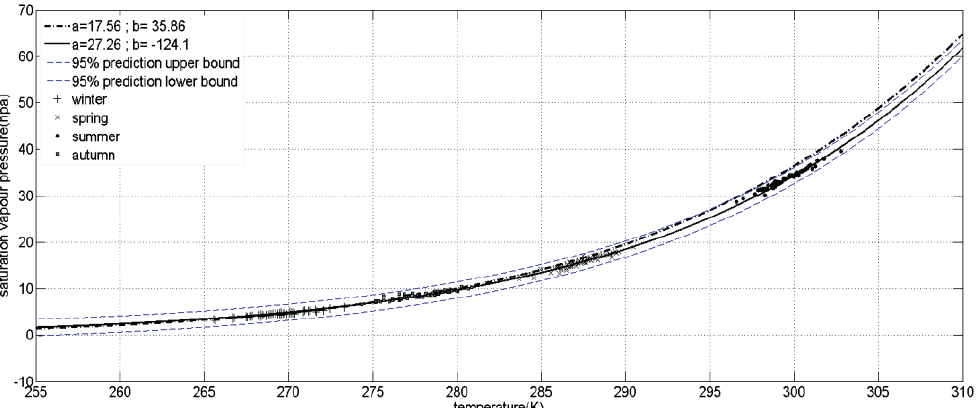
Fig. 1 Linear fitting results of C-C equation based on daily in situ observations from Beijing meteorology station during